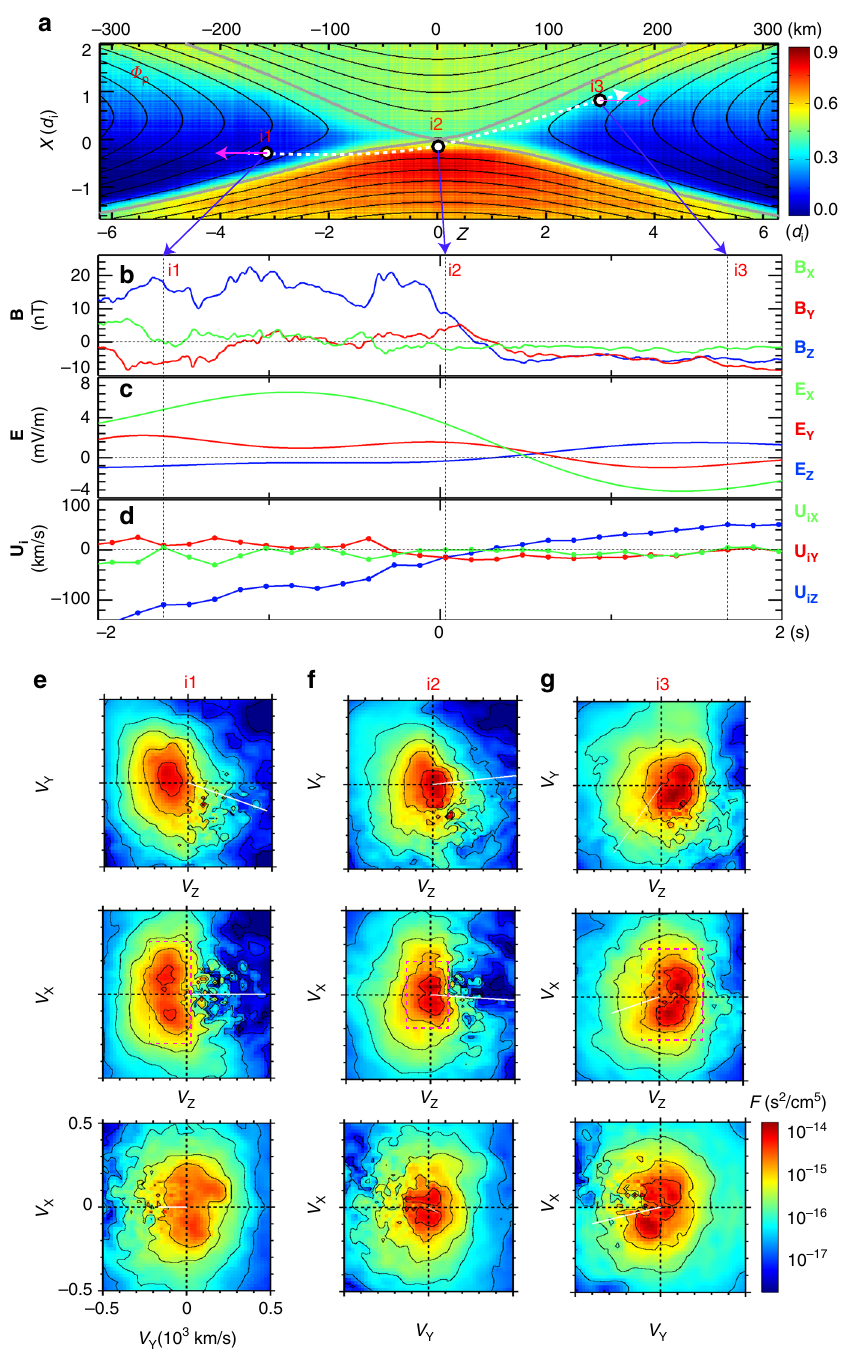
Fig. 5 MMS measurements of ion energization during magnetopause reconnection. a MMS trajectory sketched on the in-plane plasma potential from a PIC simulation. The upper half ( X > 0) is the magnetosheath (high-density side), while the lower half ( X < 0) is the magnetosphere (low-density side). b The magnetic fi eld vector components. c The electric fi eld vector components (only for frequencies f < f ci ~ 0.5 Hz, using the upstream magnetic fi eld strength). Note that E Y is about 1.6 mV m − 1 near the X-line (i2). d The ion bulk fl ow velocity vector components. The direction of the in-plane ion fl ow vector for